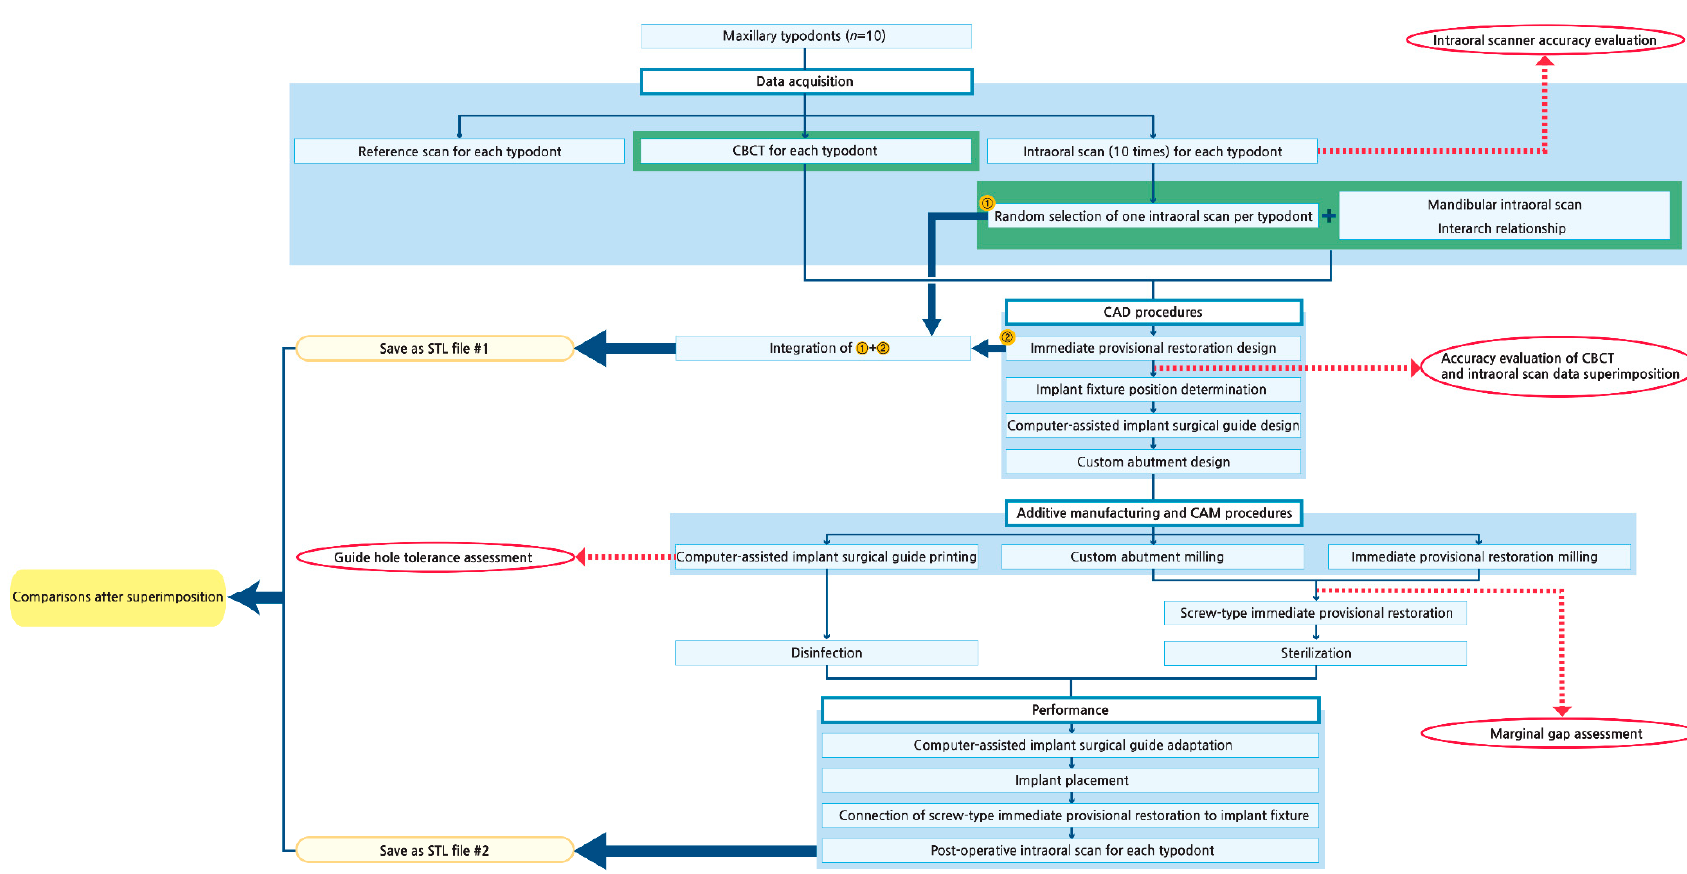
Figure 1. Schematic of the experimental protocols. CBCT, cone-beam computed tomography. CAD, computer-aided design. CAM, computer-aided manufacturing. STL, standard tessellation language.